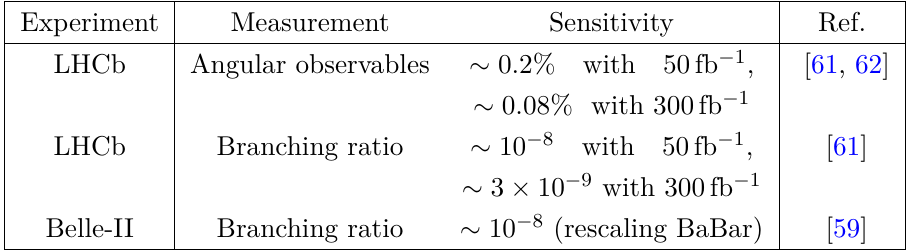
Table 9 . Summary of estimated projected experimental sensitivities from LHCb at the Upgrade I (50 fb − 1 ) and at the Upgrade II (300 fb − 1 ) for D + → π + µ + µ − and Belle-II for D + → π + e + e − , as discussed in the